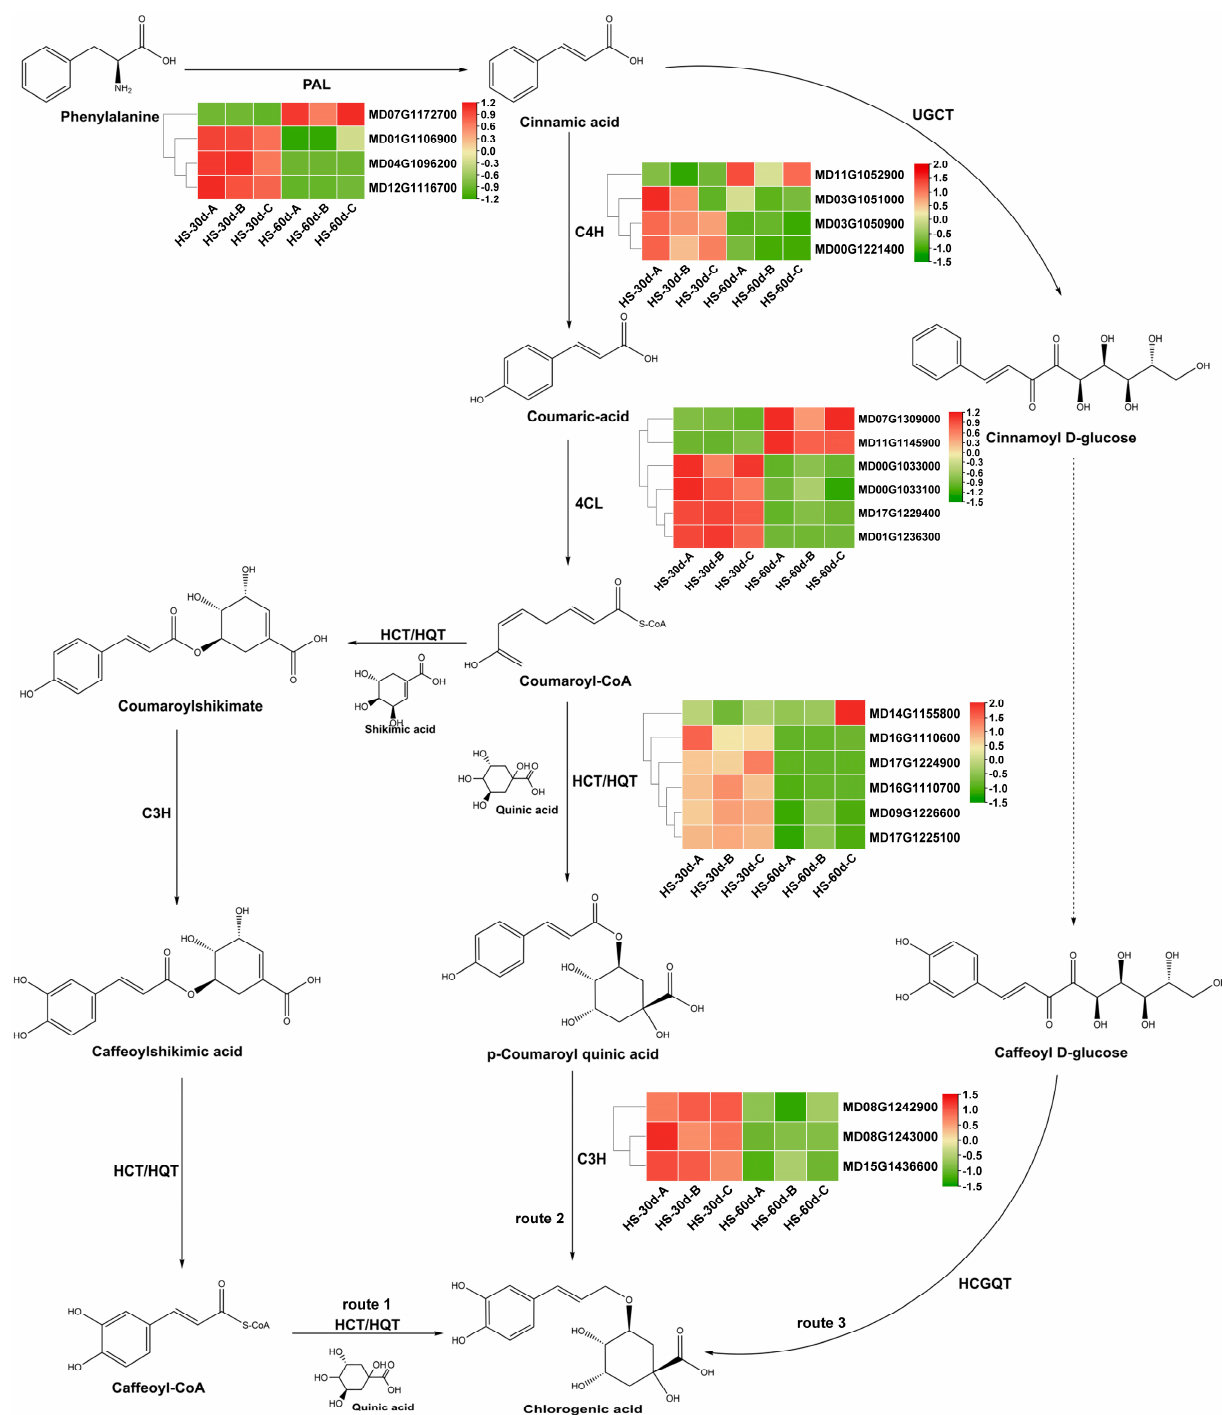
Figure 4. Schematic diagram of the CGA biosynthetic pathway and heatmaps of the expression patterns of DEGs associated with chlorogenic acid biosynthesis in ‘Huashuo’ fruits based on RNA-seq. PAL: phenylalanine ammonia-lyase; 4CL: 4-coumarate-CoA ligase; C4H: cinnamate 4-hydroxylase; C3H: p -coumarate 3-hydroxylase; HCT/HQT: hydroxycinnamoyl-CoA shikimate/quinate hydroxycinnamoyl transferase; HCGQT: hydroxycinnamoyl D -glucose: quinate hydroxycinnamoyl transferase.